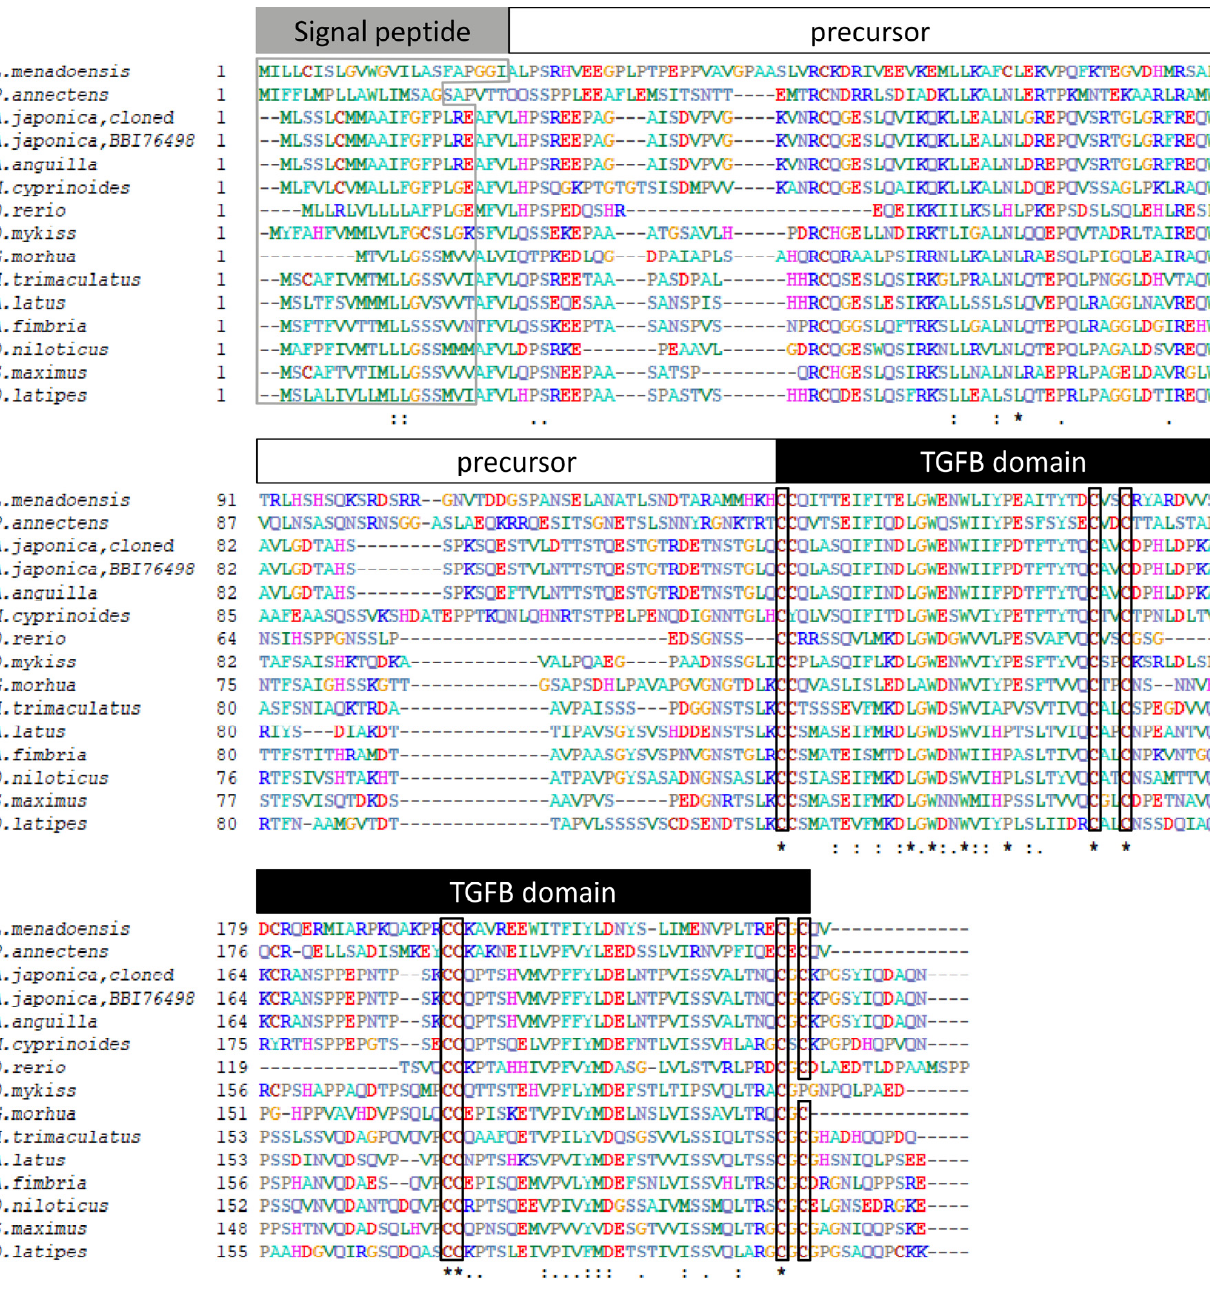
Figure 2. Alignment of the gonadal soma derived factor (Gsdf) amino acid sequences from Japanese eel and other fishes. The presumed signal peptide, precursor and transforming growth factor beta (TGF- β ) domain are indicated. Signal peptides are boxed by gray line and conserved amino acids of the cysteine knot of TGF- β domain are boxed by black line. The symbols correspond to the identity percent of amino acid sequence comparison between fishes as asterisk to 100%, two spots to 80% and one spot to 60%, respectively. The sequences used are as follows: Menado coelacanth ( Latimeria menadoensis , CCP19133), West African lungfish ( Protopterus annectens , AWT24641), Japanese eel ( Anguilla japonica , BBI76498), European